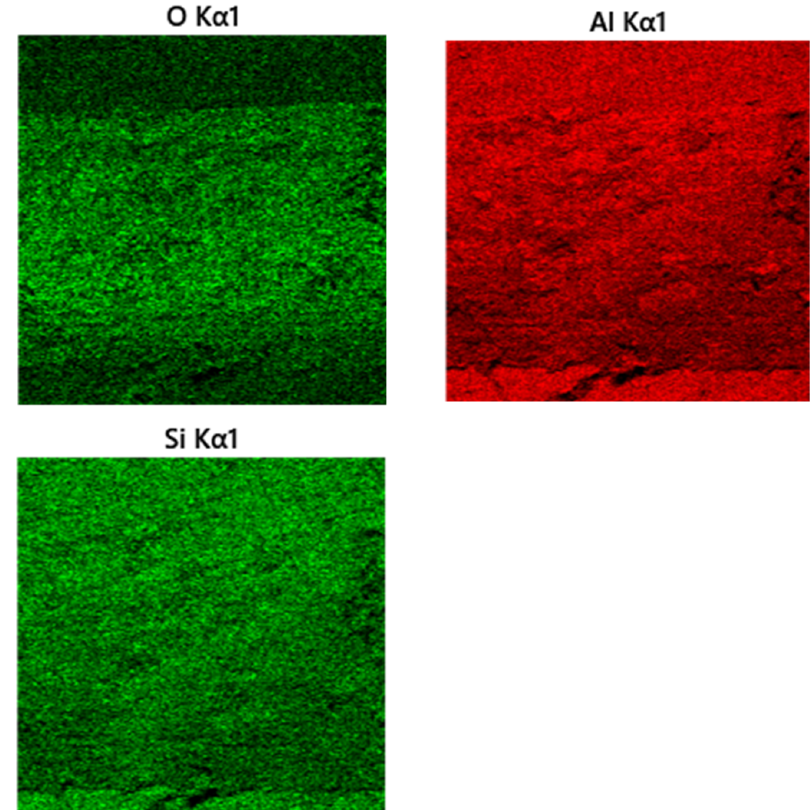
Figure 14. EDS map of the distribution of the elements of wear track in alloy in the reduced state.